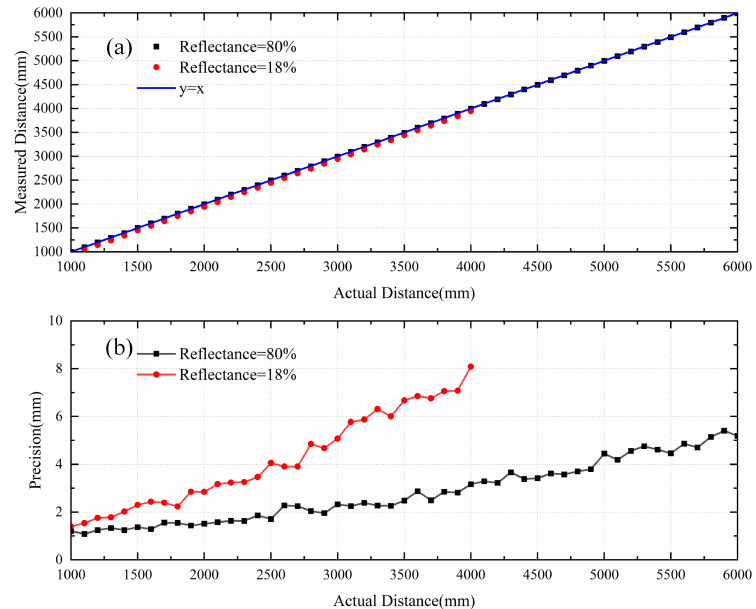
Figure 13. The linearity and depth precision vs. the actual distance larger than 1000 mm with different target reflectivity under indoor light conditions. ( a ) Linearity. ( b ) Depth precision.